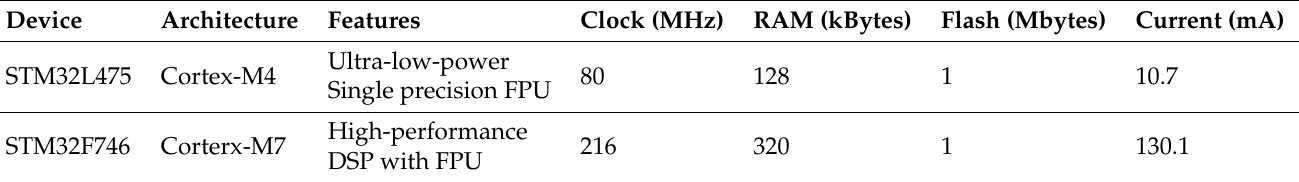
Table 1. Main features of STM32L475 and STM32F476